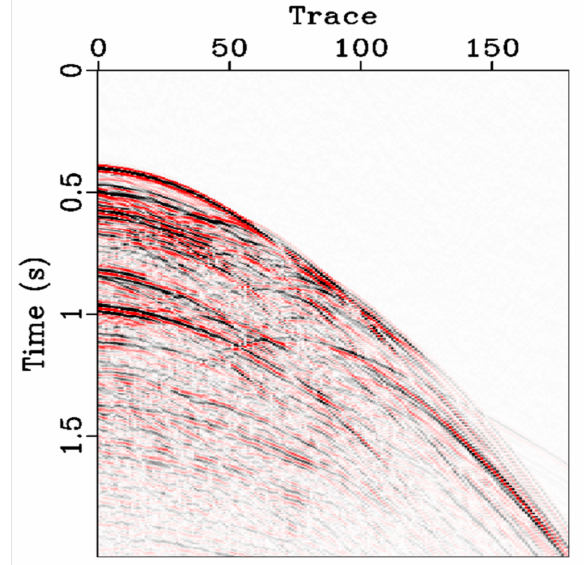
Figure 9. A common-shot gather of marine field data.